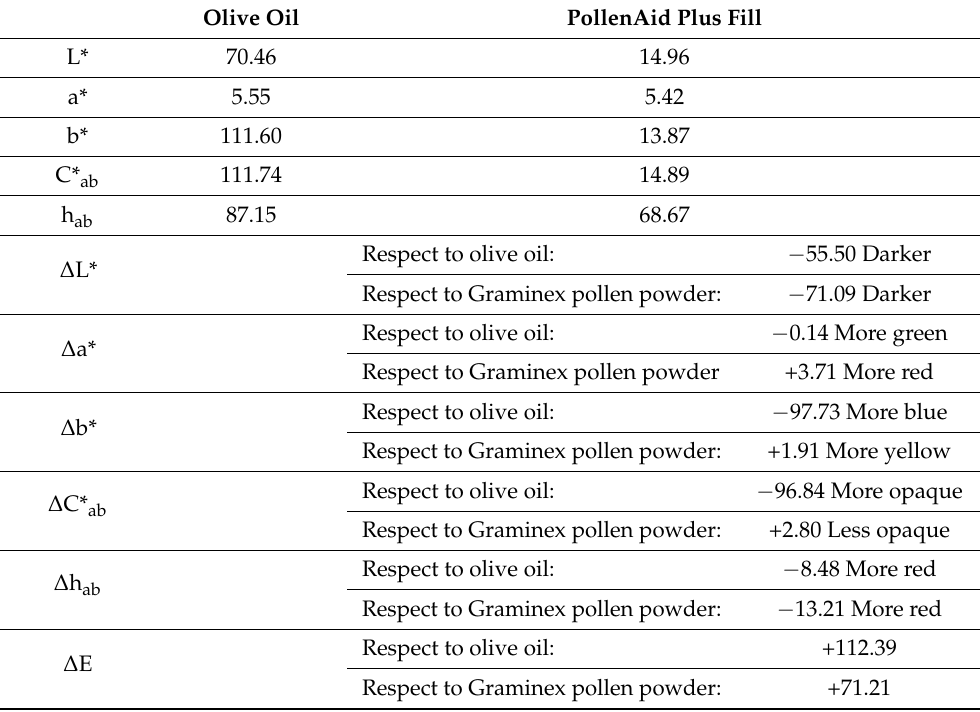
Table 1. CIEL*a*b* parameters of the carrier olive oil and of the filling formulated product. Olive Oil PollenAid Plus Fill L* 70.46